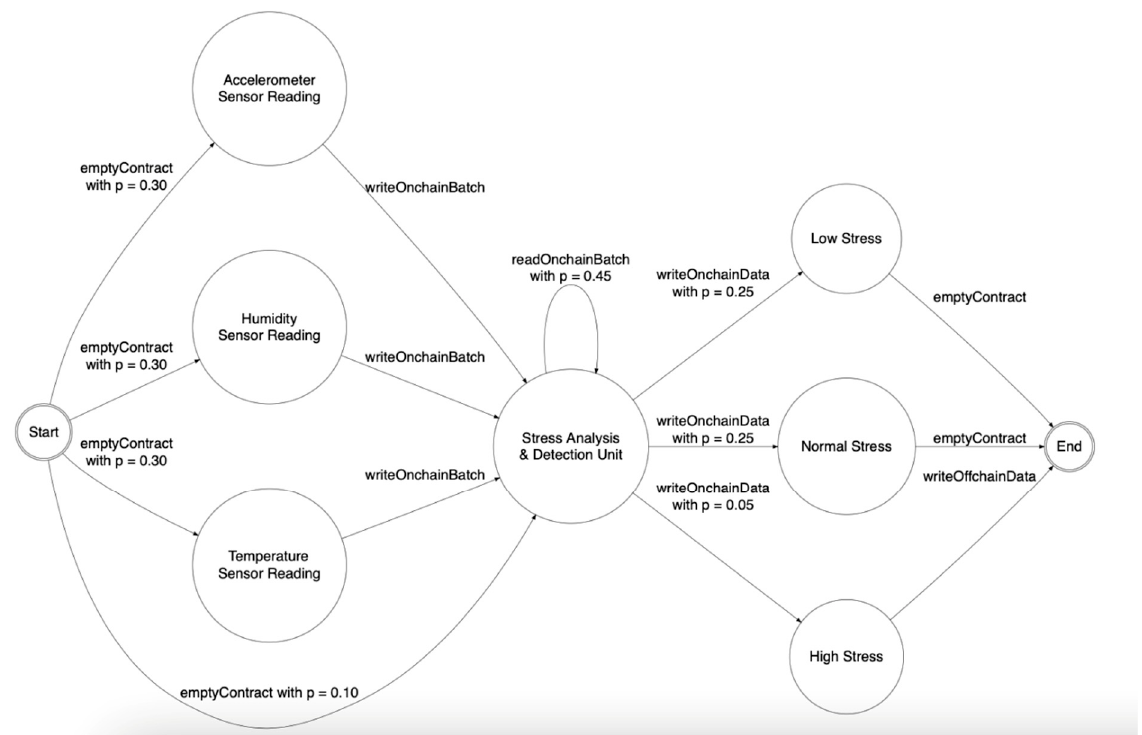
Figure 5. A possible representation of IoMT device iStress using a Probabilistic Finite Sate Machines (PFSM).